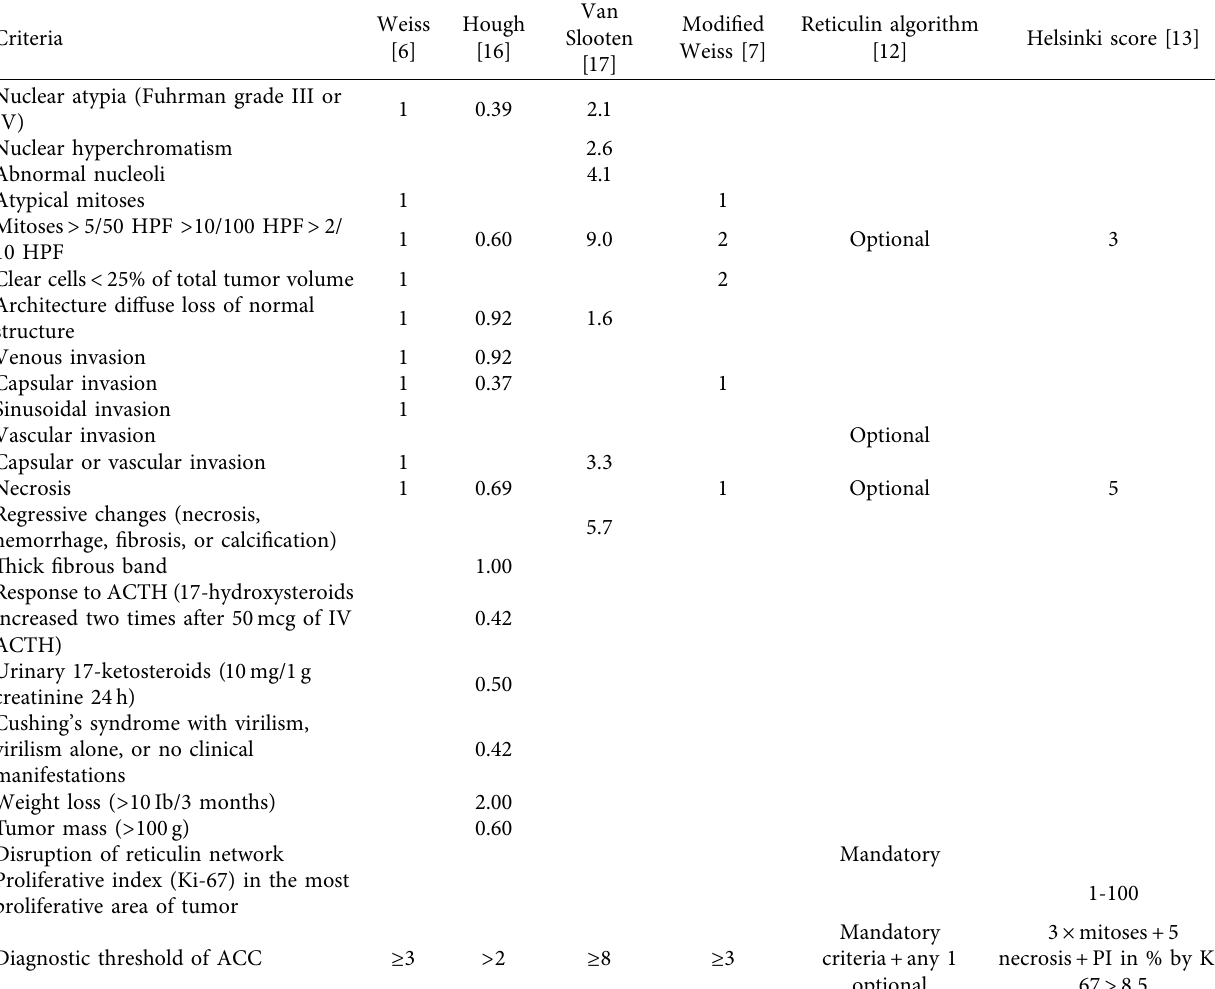
Table 3: Summary of published classification systems for adrenocortical tumors and their diagnostic threshold for adrenocortical